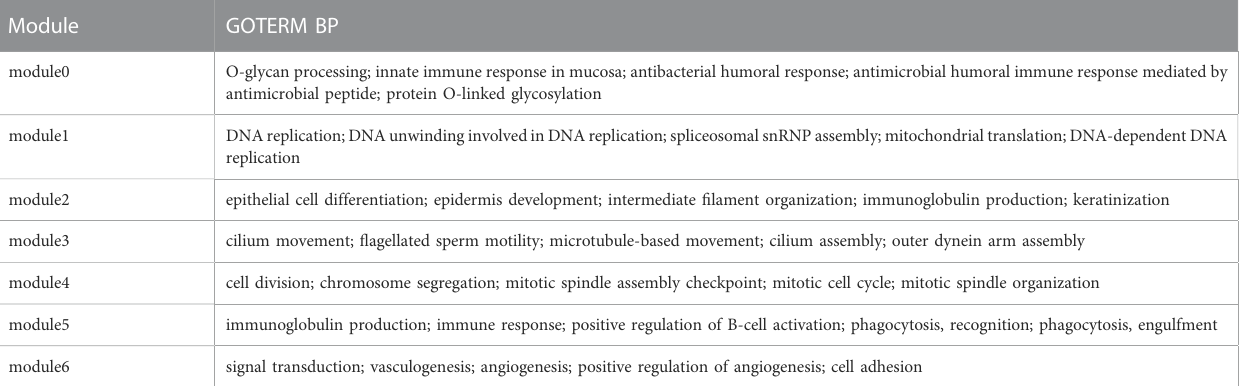
TABLE 2 GOTERM BP on LUSC